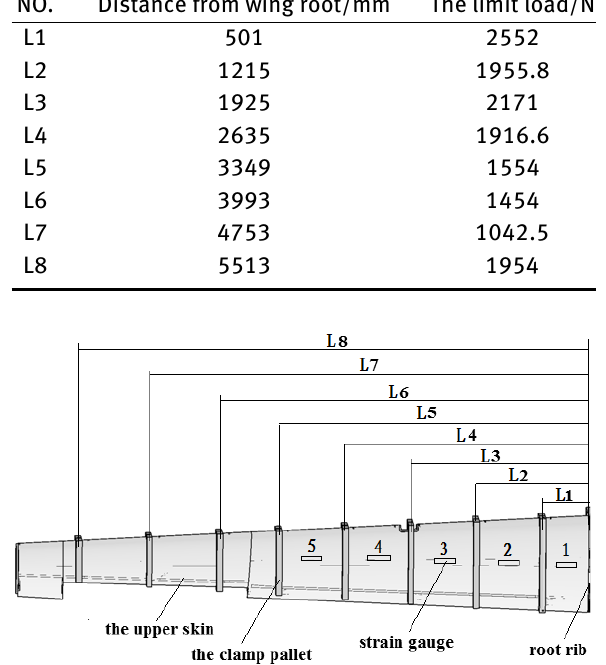
Table 3: Position and limit loads of wing clamp NO.